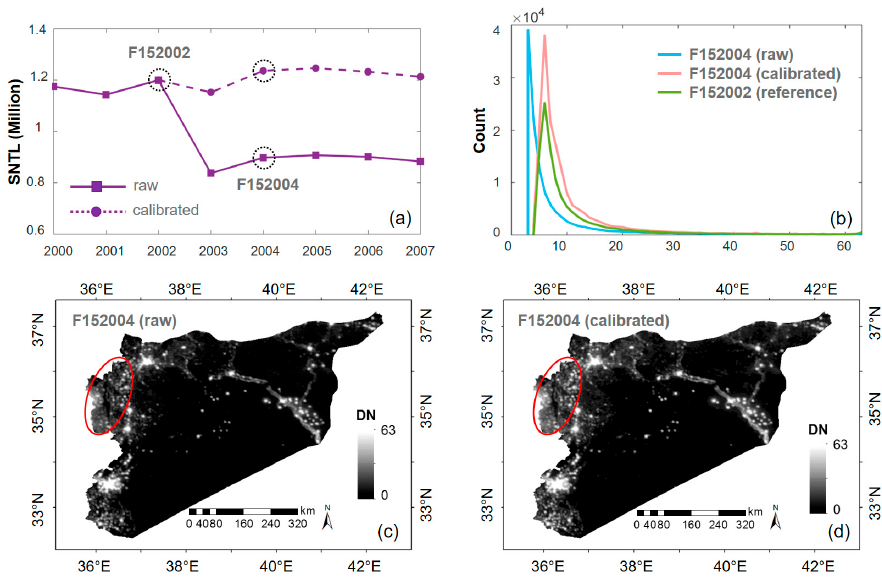
Figure 7. Illustration of stepwise calibration using NTL data of satellite F15 in Syria. ( a ) SNTL series in Syria; ( b ) DN distributions of raw F152004, calibrated F152004, and reference F152002; ( c , d ) are NTL images (F152004) before and after the stepwise calibration in Syria. Regions under red ellipses are representative areas for comparison with adjusted luminance (DN values) after calibration.